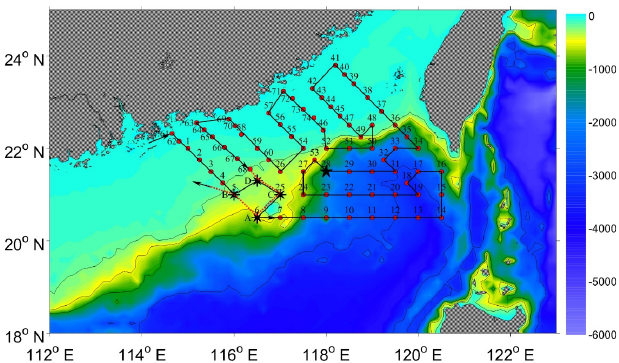
Figure 1. The map of navigational route.